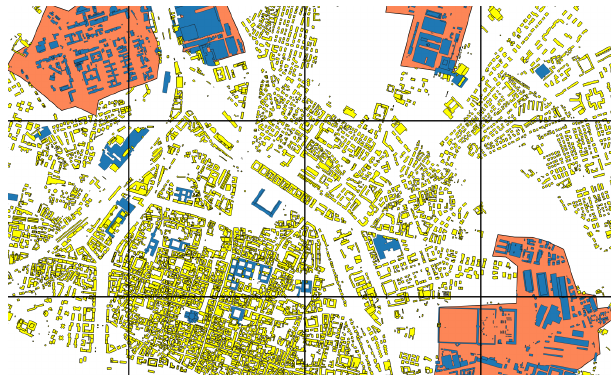
Figure 4. Municipality of Pavia – building footprints, 1km 2 grid and CORINE areas of land cover class “Industrial or commercial units” (in red). Buildings in blue are considered non-residential.